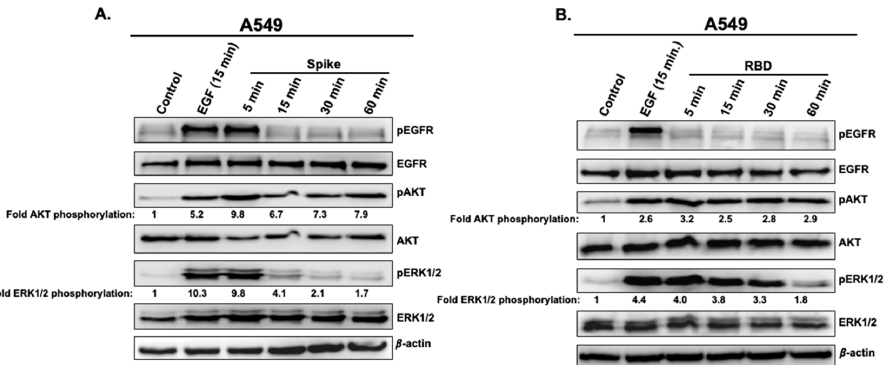
Figure 2. Time-course accumulation of pEGFR and pERK1/2 in A549 cells treated with full length Spike 1 protein and its RBD . Cells were treated or not with 2.5 µg/mL full length Spike protein ( A ) or 5 µg/mL RBD ( B ) at different times as indicated (5, 15, 30 and 60 min) and the protein levels of pEGFR and pERK1/2 and their respective total levels were determined by western blot. The treatment with EGF (5 µg/mL) was carried out for 15 min.